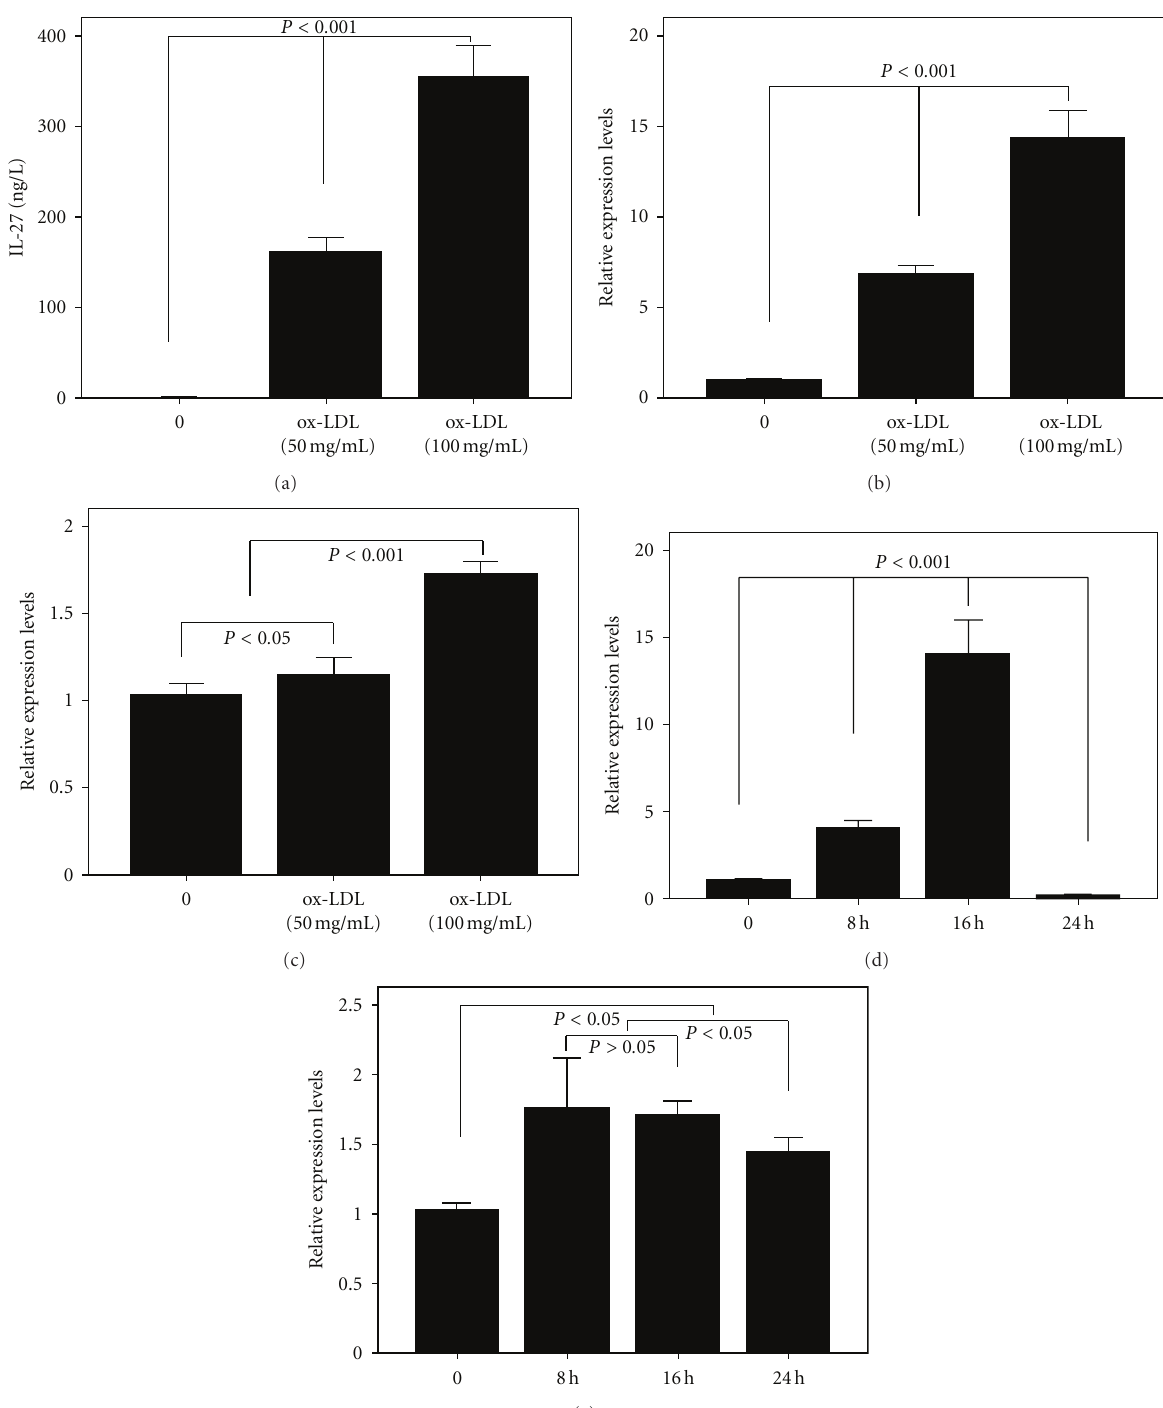
Figure 3: ox-LDL induced interleukin (IL)-27 production in monocyte-derived DCs. (a) Immature DCs were stimulated with di ff erent concentrations of ox-LDL for 24 h. The concentrations of IL-27 were analyzed using ELISA kit. (b) and (c) The mRNA expression levels of IL-27 p28 and ebi3 were evaluated by a real-time PCR analysis. The results are expressed as relative level to the control value. Results shown are means ± SD of six experiments. (d) and (e) Immature DCs were stimulated with ox-LDL (100mg/mL) for 0, 8h, 16h, and 24 h. Then the mRNA expression levels of IL-27 p28 and ebi3 were evaluated by a real-time PCR analysis. The results are expressed as relative level to the control value. Results shown are means ± SD of six